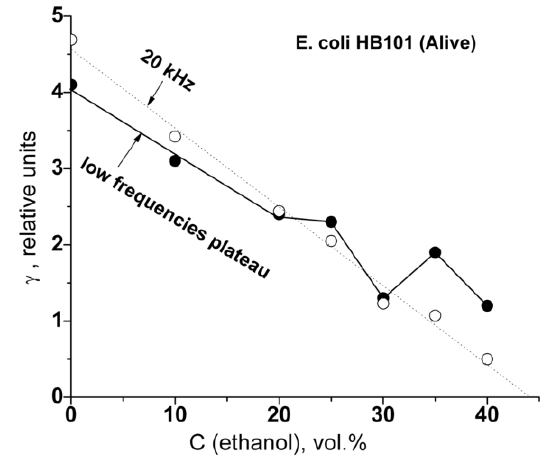
Figure 4. Dependencies of the polarizability ( γ ) of E. coli HB101 (live) cells at the plateau of the frequency dependencies (Fig. 3) on the concentration of ethanol at low and